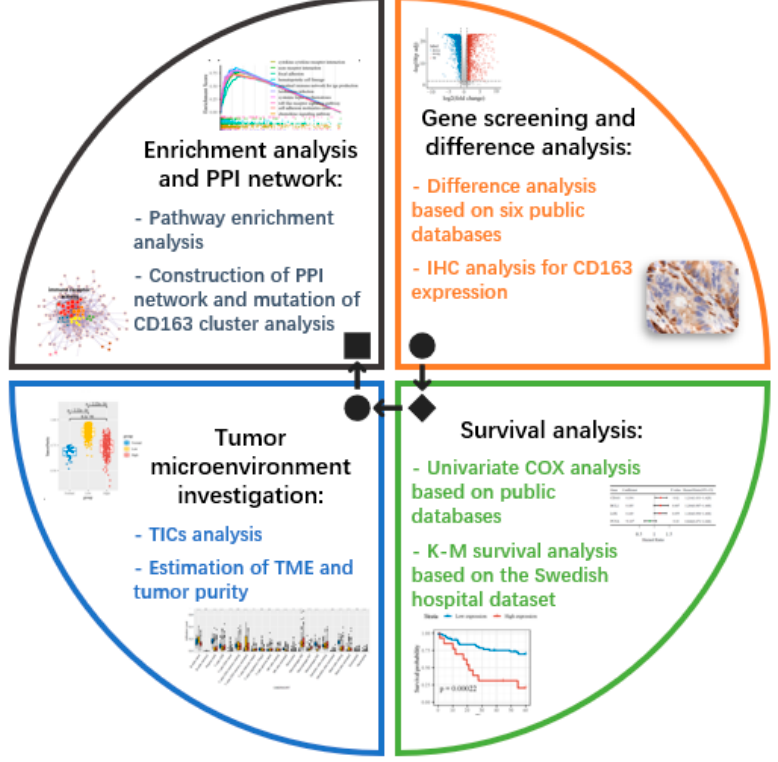
Figure 1. Research process of this present study. The structure and workflow of this investigation were divided into four parts: gene screening and difference analysis, survival analysis, TME inves- tigation and enrichment analysis, and construction of PPI network. Data mining was based on six public databases to find biomarkers with significantly different expressions, which were confirmed by tissue micro-array samples from CRC patients. As per survival data, two different methods (Cox and K-M survival analysis) were performed to determine the relationship between our factor and patient prognosis. Following the first two steps, the analysis of TME and enrichment analysis have been applied in this study to ensure the role of CD163 in TME and its possible pathways. 3.2. Expression of CD163 in CRC Patients and Survival As shown in Figure 2, CD163 was strongly expressed in the macrophages of the in- tercellular matrix of both normal and CRC tissues. CD163 was negatively to slightly ex- pressed in the normal epithelial cells (a, b, c, and d). However, CD163 was negatively (e and f), moderately (g and h), and strongly (i and j) expressed in the cytoplasm of the cancer cells.